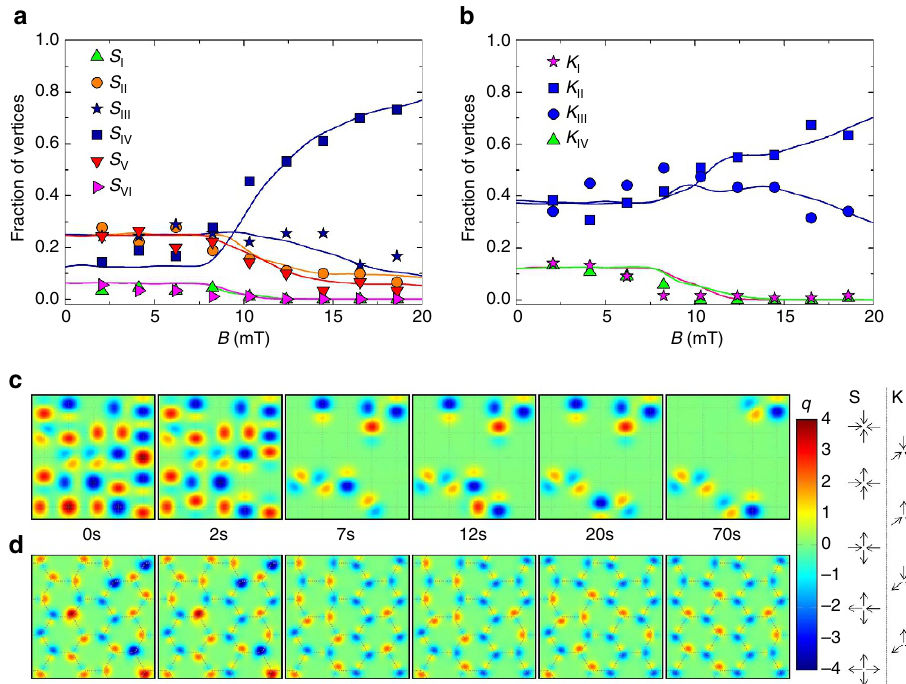
Figure 2 | Ice rules and dynamics in colloidal spin ice. ( a , b ) Average fraction of vertices at equilibrium for square ( a ) and honeycomb ( b ) ice versus the applied magnetic field. In both cases, ice-selection rules (blue) emerge for large interaction strengths. Scattered points are experimental data, continuous lines are results from Brownian dynamic simulation (Methods). The experimental points were averaged over 10 realizations, the numerical data over 1,000. ( c,d ) Evolution of the net vertex charge q in the square ( c ) and honeycomb ( d ) ice (experimental system) after the application of an external field with amplitude B ¼ 18.5mT. Point charges at each vertex were assigned by considering a positive value for an incoming spin and a negative value for an outgoing spin, relative to the centre of the vertex. The schematics on the side of the colour bar illustrate the total sum of the charges q ¼ 0; ± 2; ± 4 for the square ice and q ¼ ± 1; ± 3 for the honeycomb